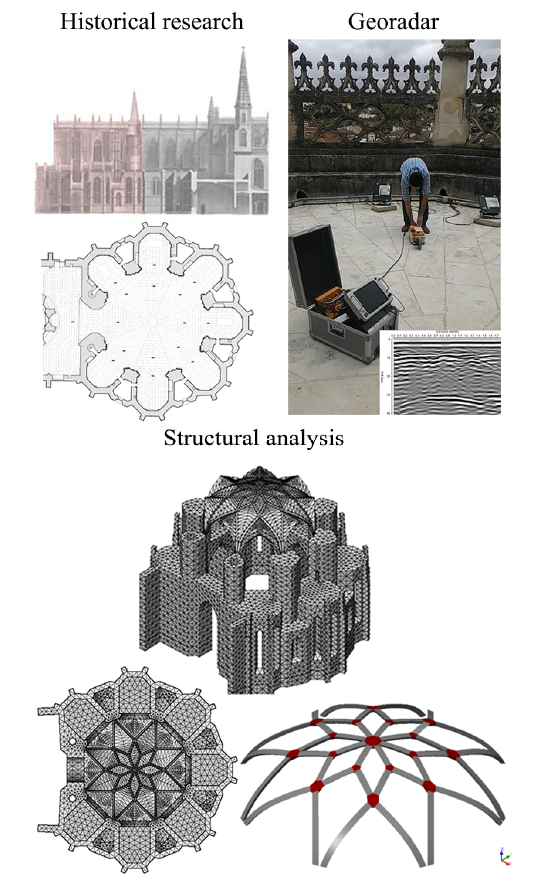
Figure 5. Conservation of cultural heritage buildings, methodology and application to case studies: Imperfect Chapels of Batalha Monastery in Portugal